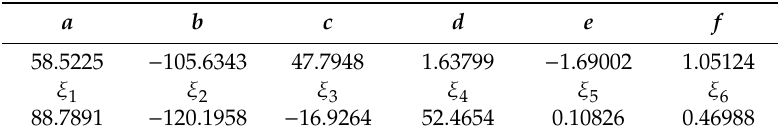
Table 2. Constant value for